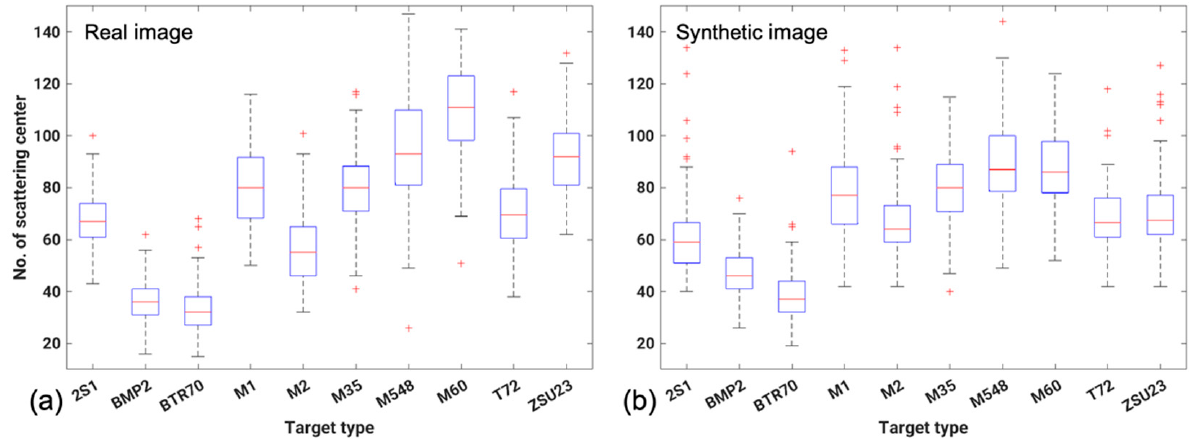
Figure 8. Box plot of the number of scattering centers. ( a ) Real SAR image (16°, 17°) and ( b ) synthetic SAR image (16°, 17°).